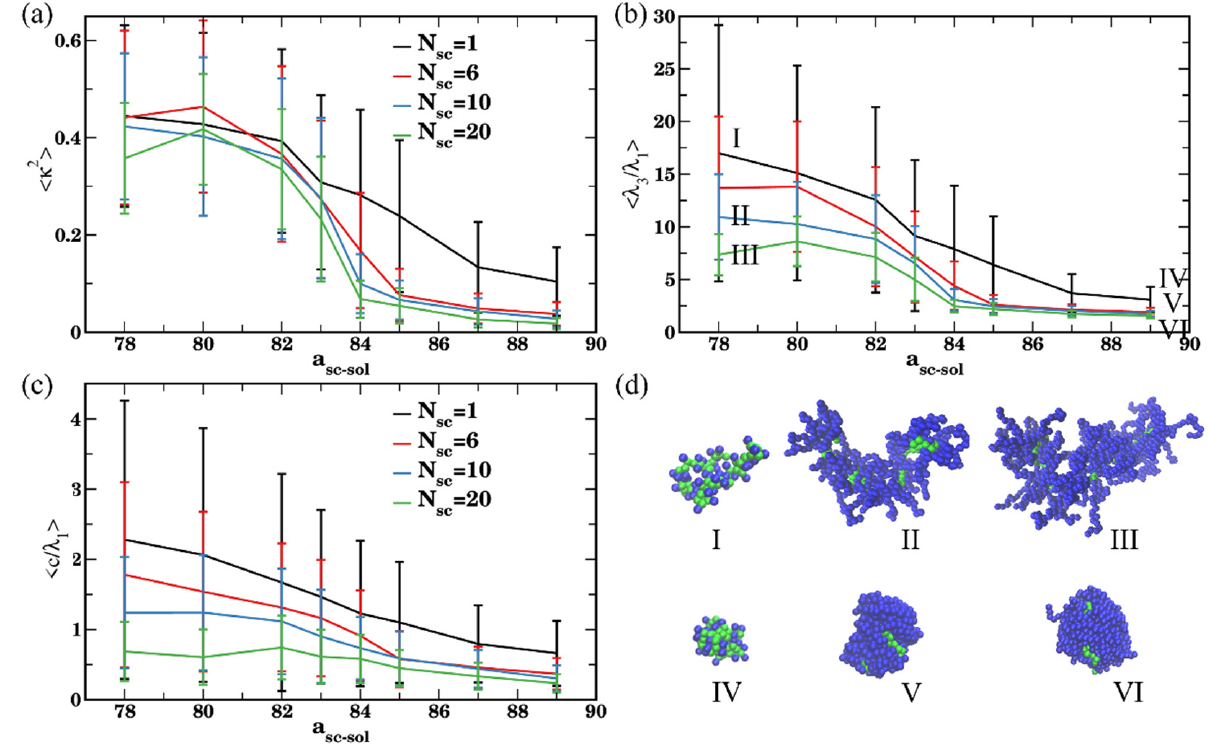
Figure 3. ( a ) Shape anisotropy κ 2 , ( b ) ratio of eigenvalues λ 3 / λ 1 , and ( c ) acylindricity c normalized by the eigenvalue λ 1 . The data are averaged over last 6 × 10 6 steps (1200 frames), error bars represent standard deviations. Black, red, blue, and green curves correspond to N sc = 1, 6, 10, and 20, respectively. ( d ) Late time snapshots for bottlebrushes with N sc = 1 in good and poor solvents (a sc-sol = 78 in (I), a sc-sol = 89 in (IV), respectively), bottlebrushes with N sc = 10 in good and poor solvents (a sc-sol = 78 in (II), a sc-sol = 89 in (V), respectively), and bottlebrushes with N sc = 20 in good and poor solvents (a sc-sol = 78 in (IV) and a sc-sol = 89 in (VI), respectively). Same trends are further confirmed by comparing an average ratio between the largest and smallest eigenvalues, < λ 3 / λ 1 > (Figure 3b), and an average acylindricity normal- ized on the smallest eigenvalue, (cid:104) c / λ 1 (cid:105) (Figure 3c). The normalization on the λ 1 in the latter plot is needed for more direct comparison between the structural characteristics of macromolecules with highly disparate dimensions; the acylindricity c , as well as λ 2 / λ 1 ratios are provided in Figure S2. These plots confirm that the bottlebrushes remain highly globular for N sc = 6, 10, and 20 at high a sc-sol while for N sc = 1 both < λ 3 / λ 1 > and (cid:104) c / λ 1 (cid:105) remain relatively high even at the highest a sc-sol considered. For the solvents with high affinity to the side chains, the values (cid:104) c / λ 1 (cid:105) decrease with an increase in N sc , indicating the lowest acylindricity normalized per smallest linear size in the system for the macro- molecules with the longest side chains. We also note large error bars in the calculated values in Figure 3a–c for all the cases except the cases corresponding to nearly globular conformations. These large error bars indicate a broad distribution of macromolecular conformations upon equilibration and are on the same scale as observed in the prior studies of shape anisotropy of various polymers